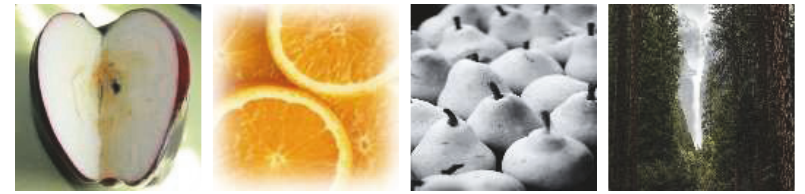
Figure 7: Training samples. These bad training samples may cause the failure of image translation.